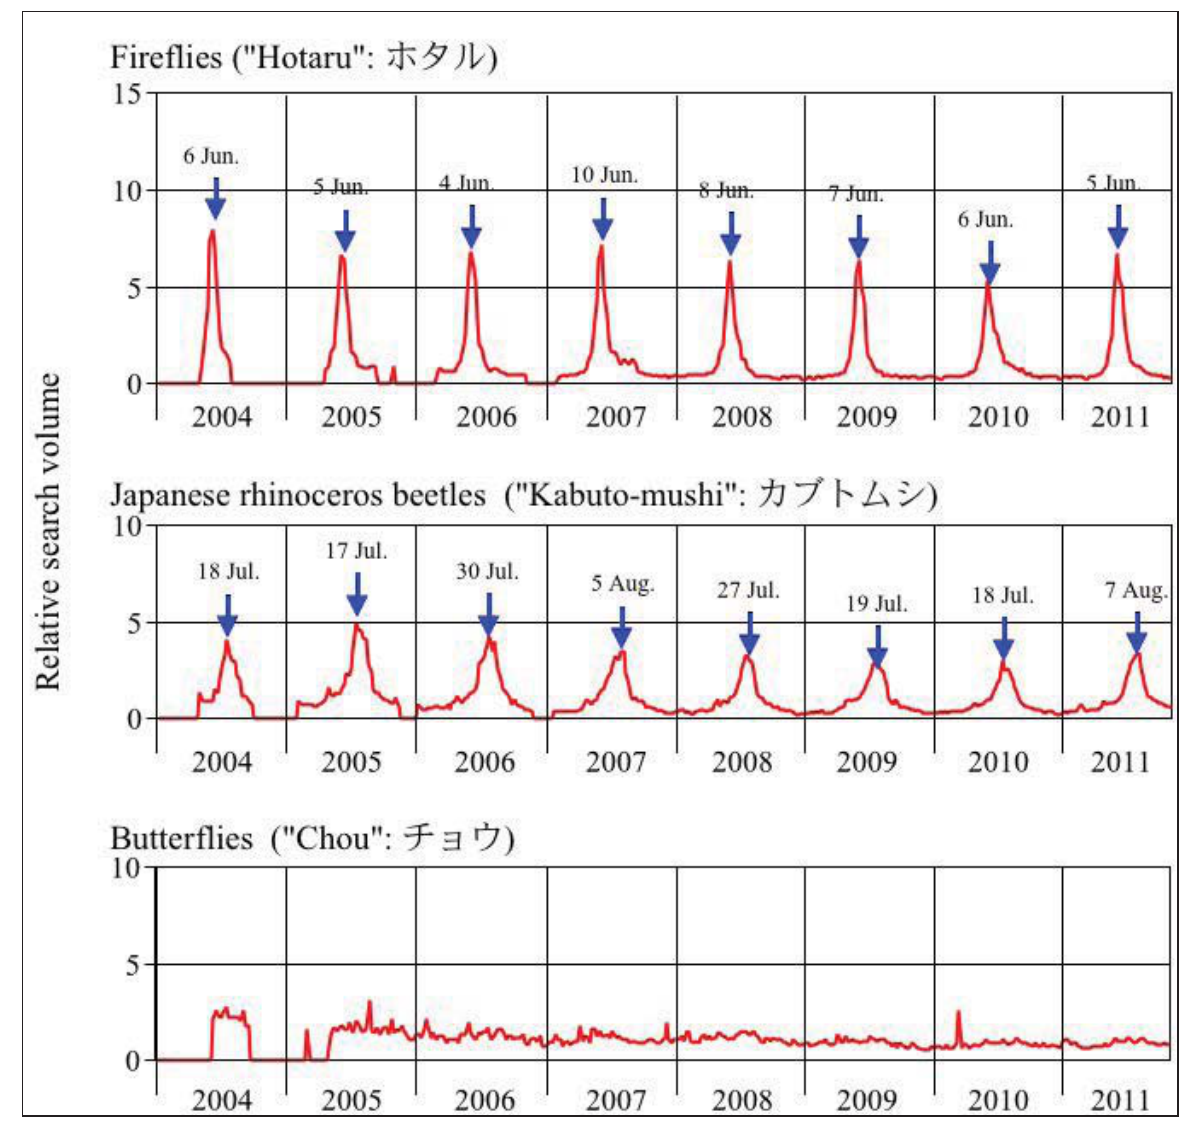
Figure 2. Seasonal change in relative search volume index for “Hotaru” (fireflies) and “Kabuto-mushi” (Japanese rhinoceros beetles) Relative search volume index for the control term “Chou” (butterflies) is plotted over